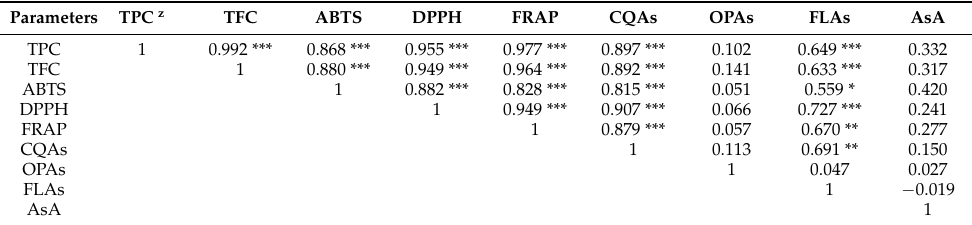
Table 7. Correlation matrix (r coefficients) between bioactive compounds, antioxidant capacity, and phenolic groups identified by LC-MS and AsA content in 18 native Greek rock samphire genotypes. Parameters TPC z